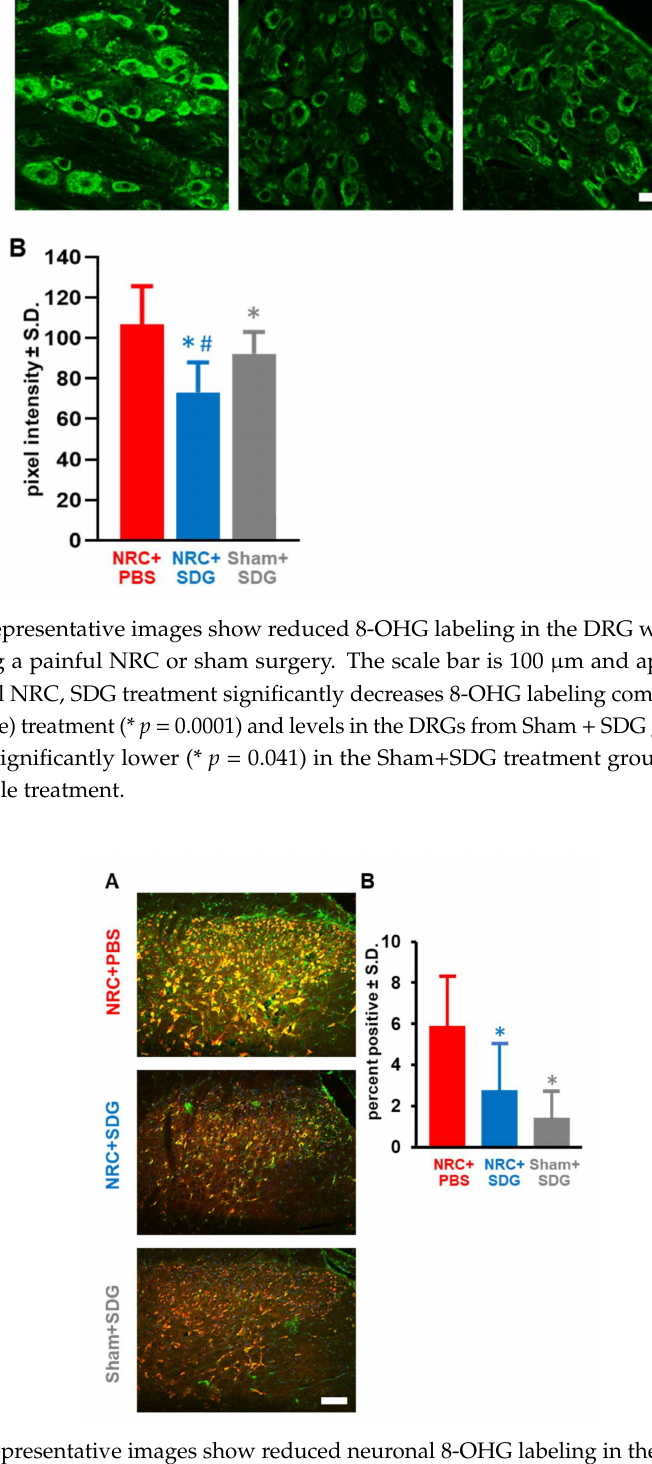
Figure 4. ( A ) Representative images show reduced neuronal 8-OHG labeling in the spinal cord in rats receiving either a painful NRC or sham surgery with SDG treatment (scale bar is 100 µ m and applies to all panels). ( B ) Spinal neuronal 8-OHG labeling after a painful NRC is significantly reduced with SDG treatment (* p = 0.0001) to sham levels. Similarly, the sham SDG-treated group shows a significant reduction (* p = 0.0007) in spinal neuronal 8-OHG compared to the NRC + PBS